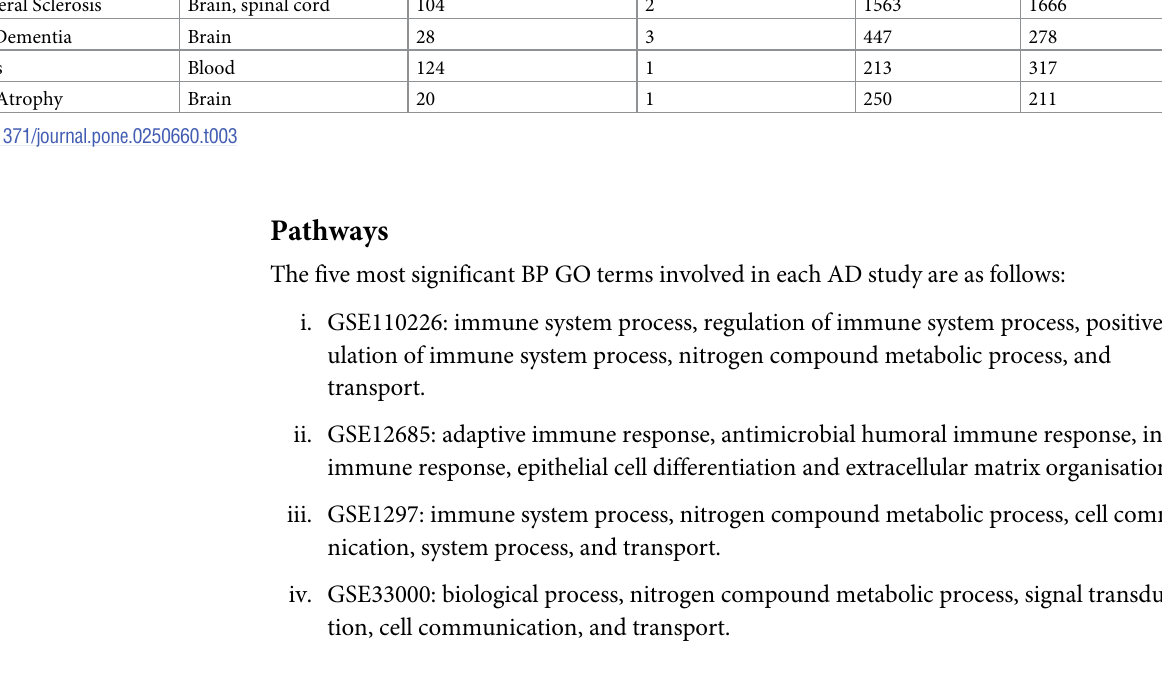
Table 3. Summary of findings in the steps of the pipeline for the datasets of the selected pathologies.